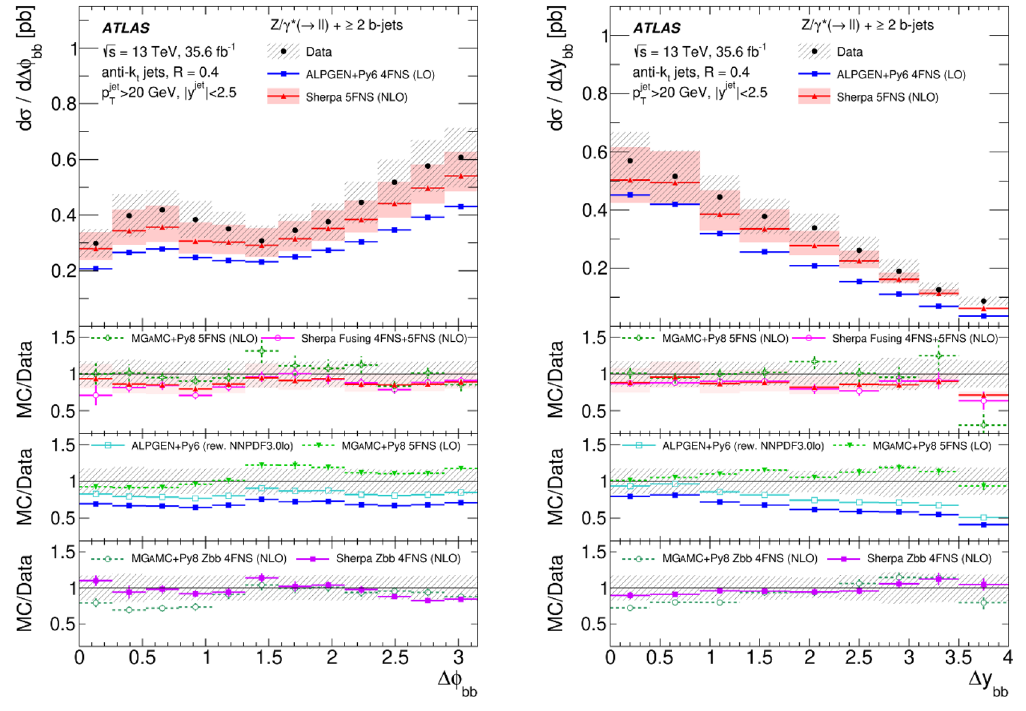
Figure 12 . Measured cross-section as a function of (cid:1) (cid:30) (left) and (cid:1) y between the two leading b -jets (right) in events with at least two b -jets. The data are compared with the predictions from Sherpa 5FNS (NLO) , Alpgen + Py6 4 FNS (LO) , Sherpa Fusing 4FNS+5FNS (NLO) , Sherpa Zbb 4FNS (NLO) , MGaMC + Py8 5FNS (LO) , MGaMC + Py8 Zbb 4FNS (NLO) and MGaMC + Py8 5FNS (NLO) . The error bars correspond to the statistical uncertainty, and the hatched bands to the data statistical and systematic uncertainties added in quadrature. The red band corresponds to the statistical and theoretical uncertainties of Sherpa 5FNS (NLO) added in quadrature. Only statistical uncertainties are shown for the other